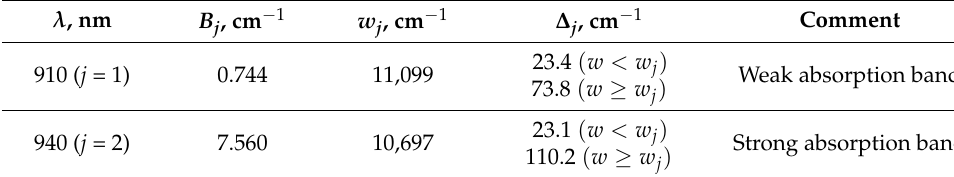
Table 1. The parameters of water vapor absorption model